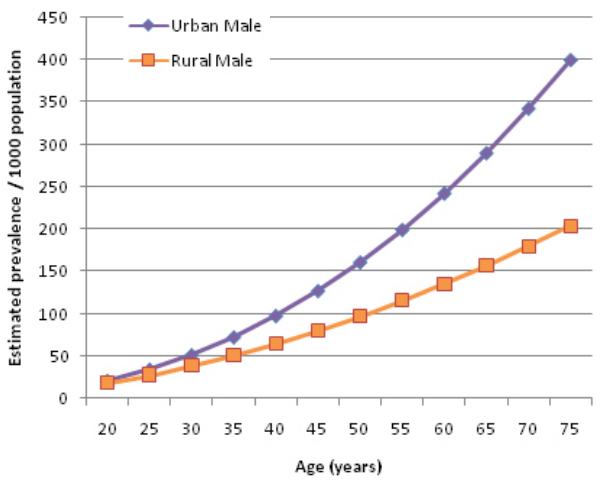
Figure 11. Comparison of the prevalence of type 2 diabetes in Southern Asia by age in urban and rural regions – men only.